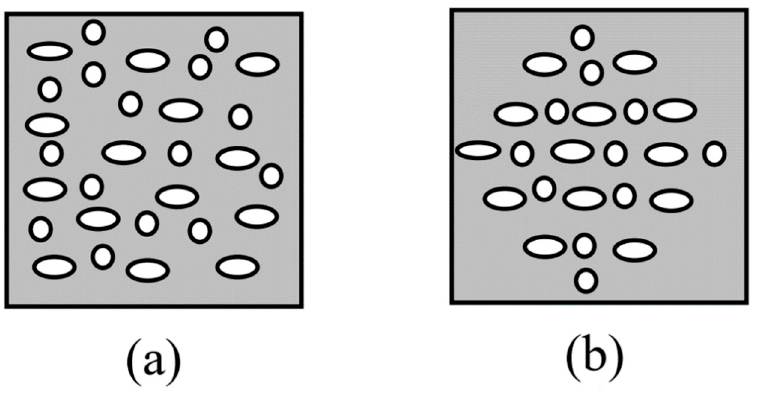
Figure 2. Distribution of porosity: ( a ) even porosity, ( b ) uneven porosity.